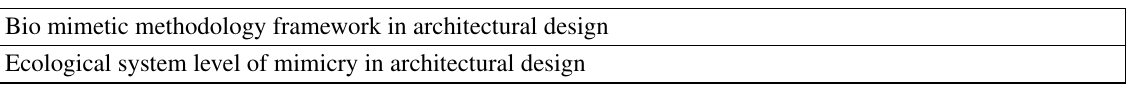
Table 4. showing mimicry of ecological system in balancing the building with nature. Source: collated by the writer. Bio mimetic methodology framework in architectural design Ecological system level of mimicry in architectural